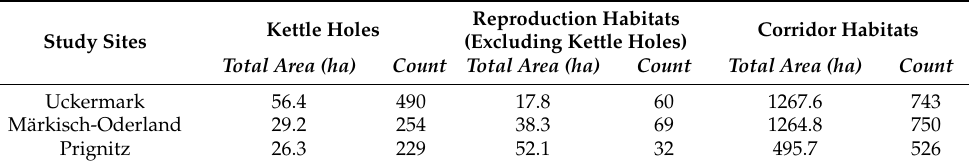
Table 2. The total area (ha) and number of kettle holes and of other wetland habitats suited for the reproduction of amphibian species in Uckermark, Märkisch-Oderland, and Prignitz. Data for kettle holes refer to perennial kettle holes only; their total area was estimated based on their number and an average size value derived from Hoffmann et al.